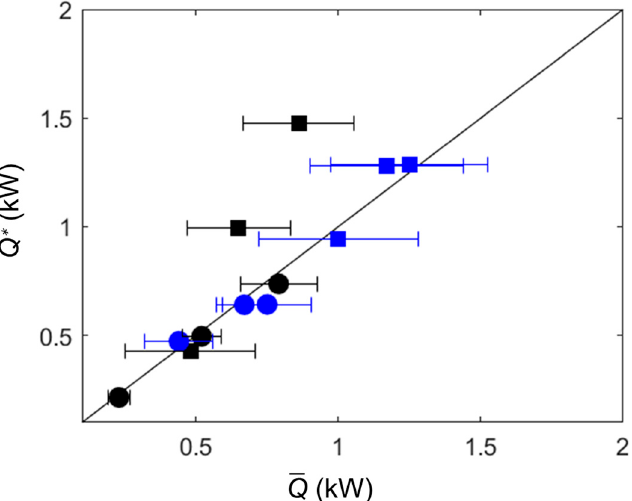
∗ and the measured heat